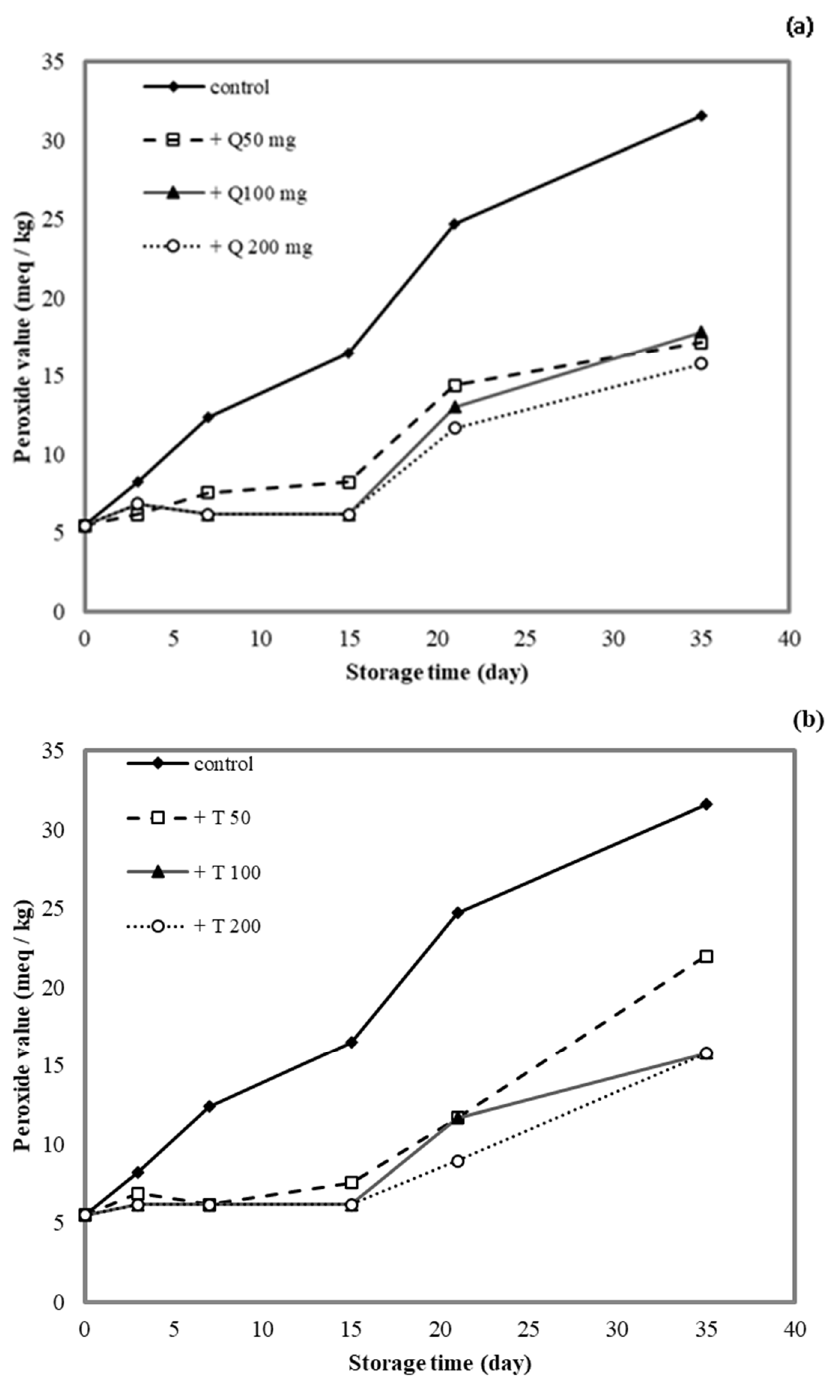
Figure 9. Effect ( a ) quercetin and ( b ) TBHQ addition into cassava starch/gelatin films on the peroxide value of lard.